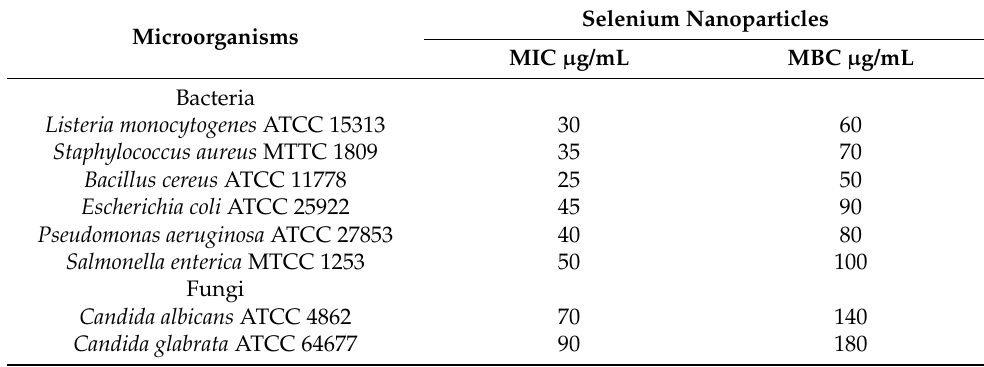
Table 3. The MIC (Minimum Inhibitory Concentration), MBC (Minimum Bactericidal Concentration), and MFC (Minimum fungicidal concentration) of the selenium